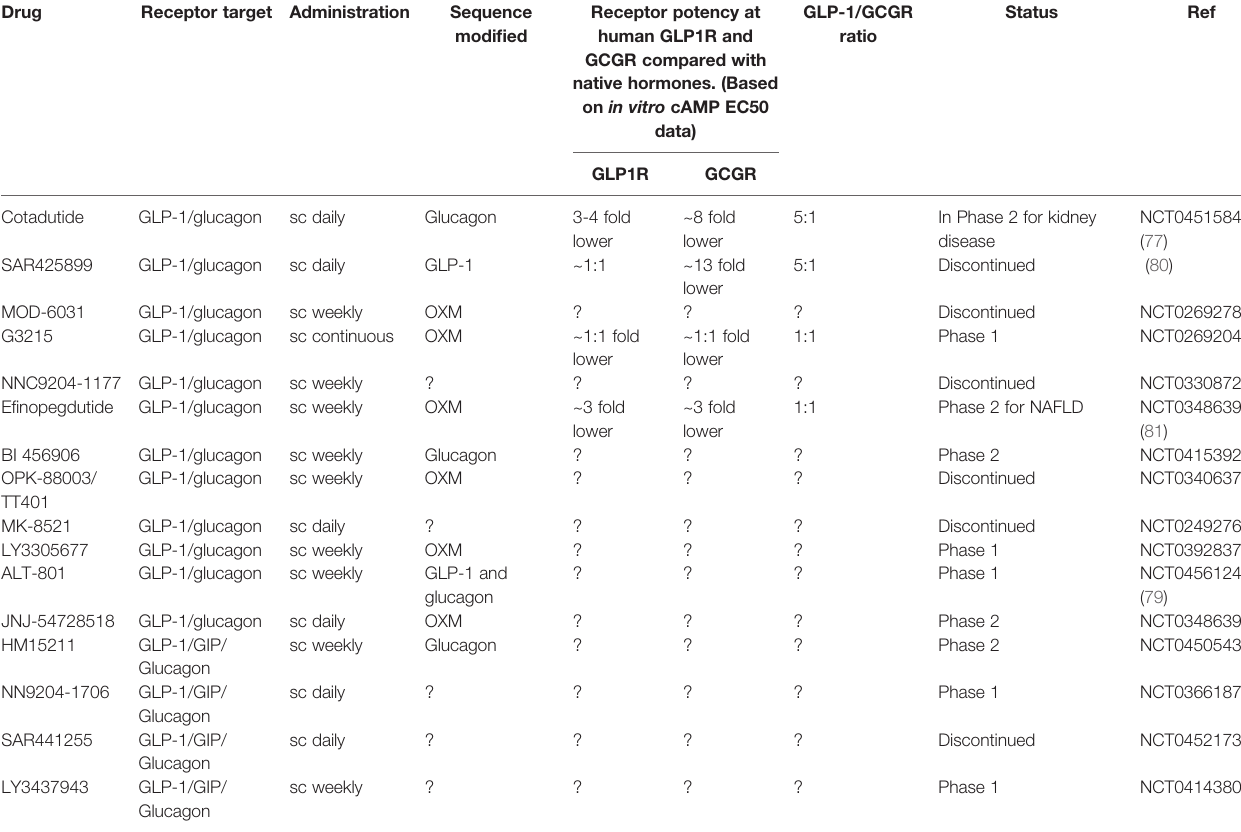
TABLE 1 | Current glucagon containing anti-obesity drugs in